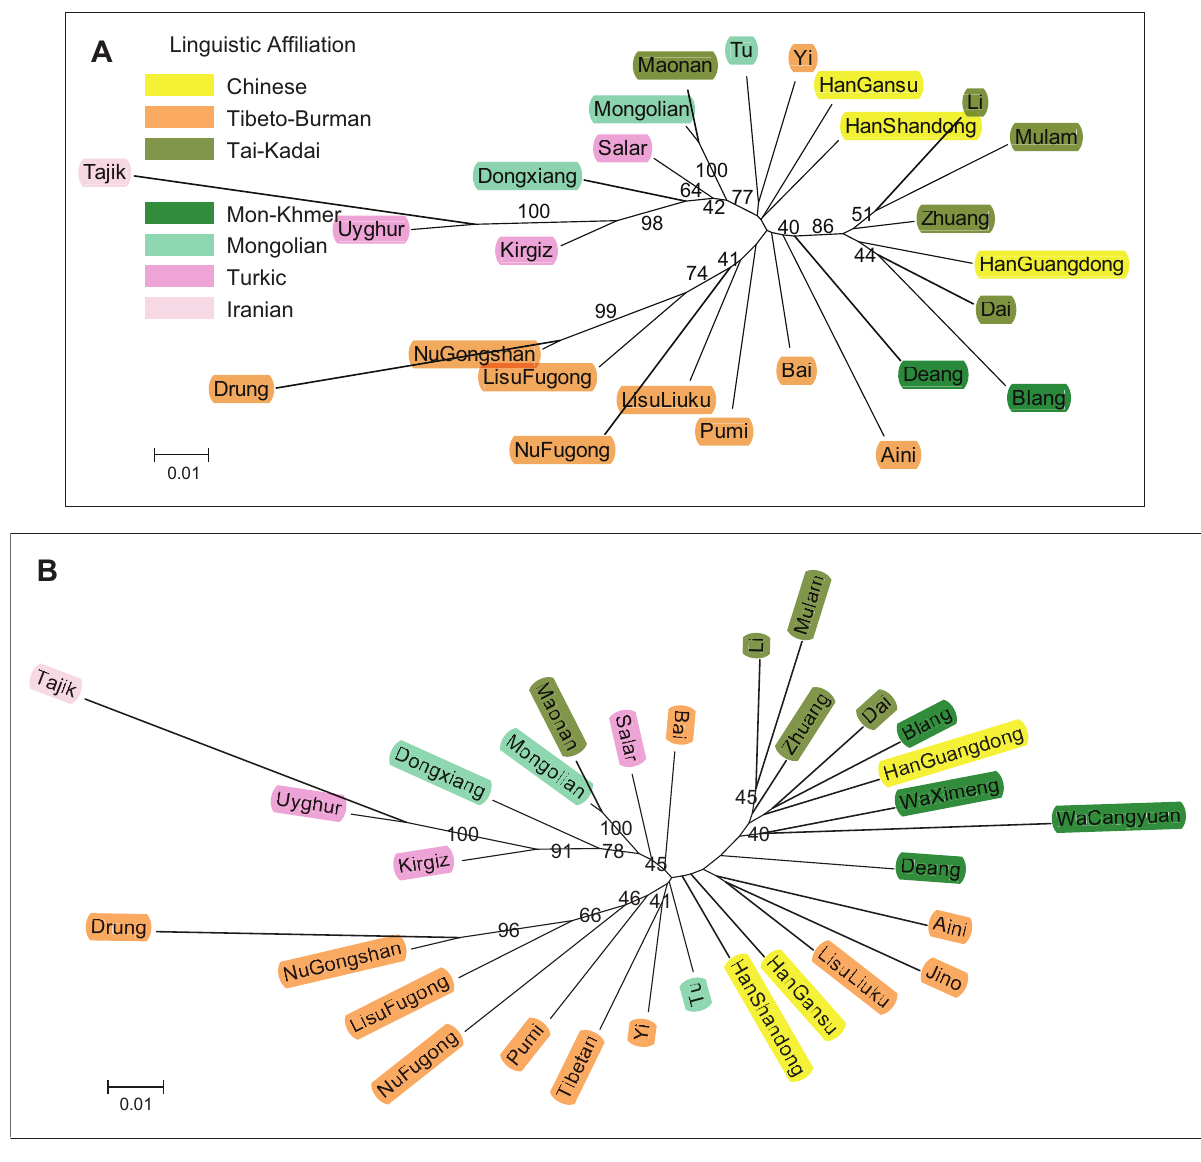
Figure 2. Unrooted neighbor-joining trees constructed with D A distances. (A) is the full-loci dataset and (B) the full-population dataset. Numbers labelled here represent percentage of occurrence of corresponding branches in 1,000 bootstrap replicates (where only values . 40% are shown). Names of populations were coloured according to their linguistic affiliations.